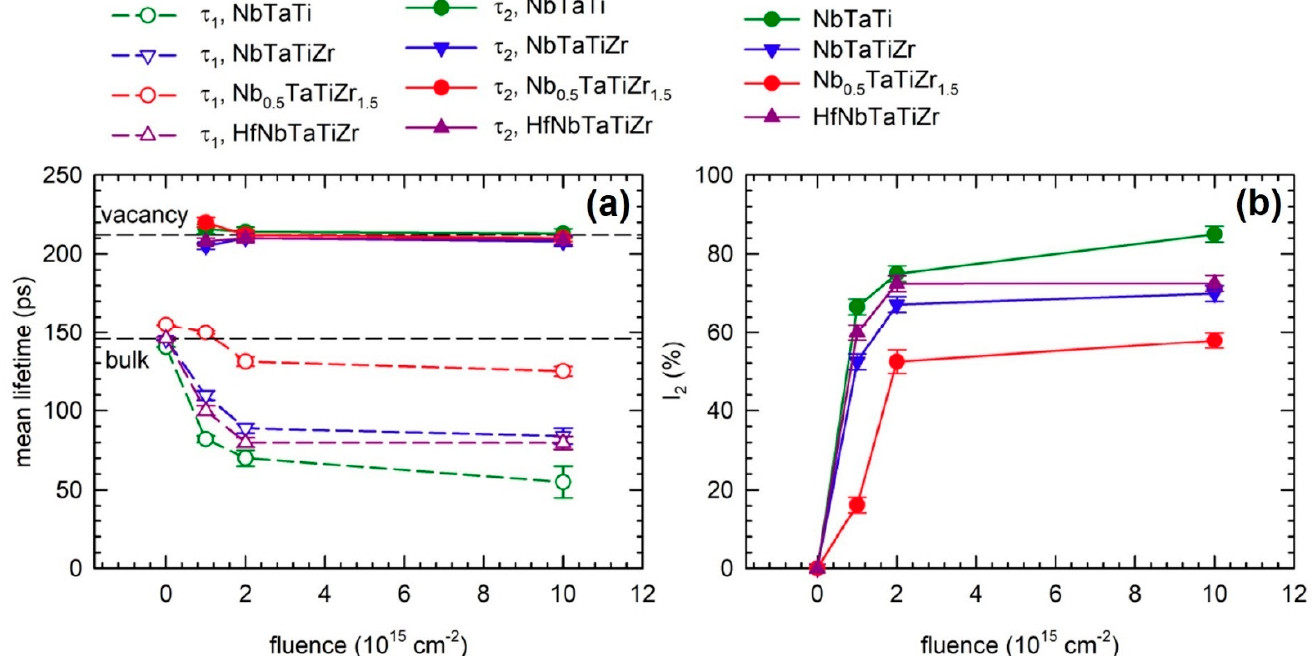
Figure 9. Results of decomposition of LT spectra: ( a ) the development of lifetimes τ 1 , τ 2 of the exponential components resolved in LT spectra, and ( b ) intensity I 2 of positrons trapped in irradiation-induced defects .